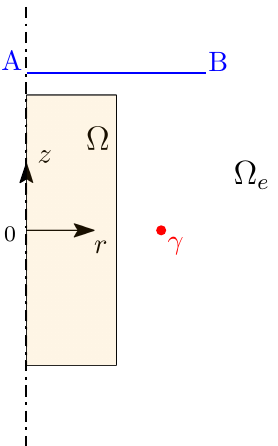
Figure 1. Axisymmetric inductor: a billet (4 cm long and 1 cm radius) is excited by a current loop γ (1.5 cm radius and 1000 A); the magnetic flux density was computed along line AB (0 ≤ r ≤ 3 cm and z = 2.5